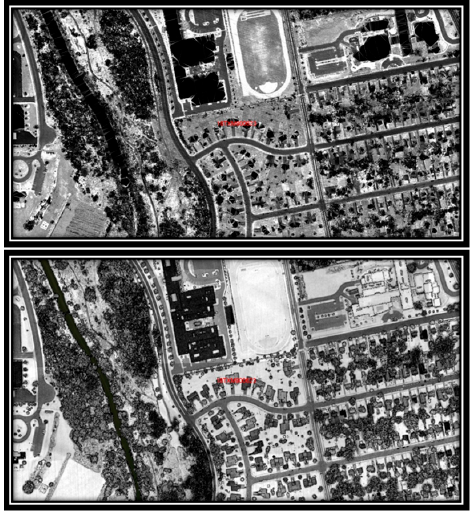
Figure 6. Example of an intensity image from: a linear-mode system ( top ); and the IntelliEarth™ system ( bottom ).